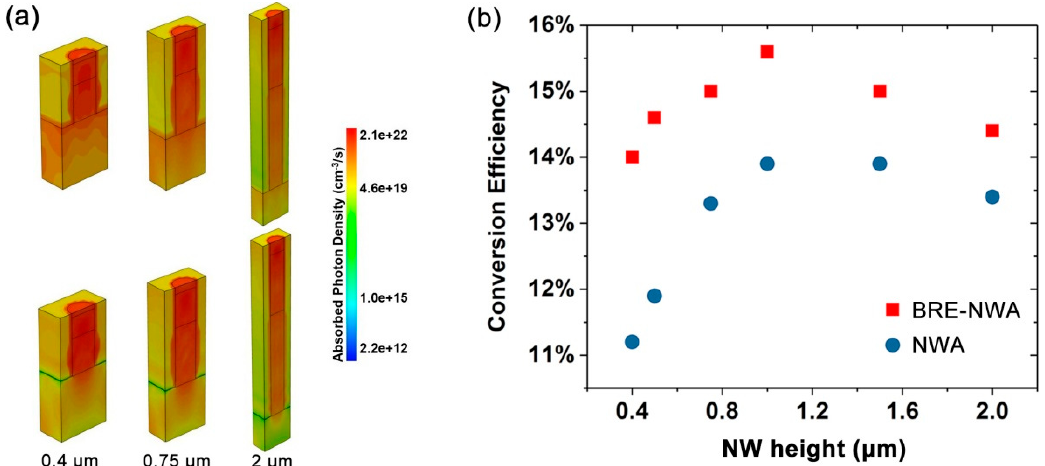
Figure 5. ( a ) 3-D total optical generation profiles in the NWA and BRE-NWA structures with a NW height of 0.4, 0.75, and 2 μ m, respectively. ( b ) Conversion efficiency comparison of NWA and BRE-NWA structures with different NW heights.